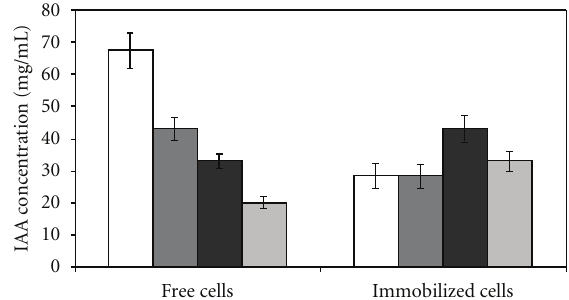
Figure 2: Initial biomass e ff ect on IAA production by immobilized cells of Klebsiella oxytoca on 6% SiO 2 /TiO 2 and 10% SiO 2 /MnO 2 matrices ((white bar) 0.3 g, (grey bar) 0.6 g, and (black bar) 1.2g of immobilized cells). Conditions: nitrogen-free malate (NFb) medium, 1000.0 μ gmL − 1 of L -tryptophan, pH 6.8, 28 ◦ C, and 120rpm.